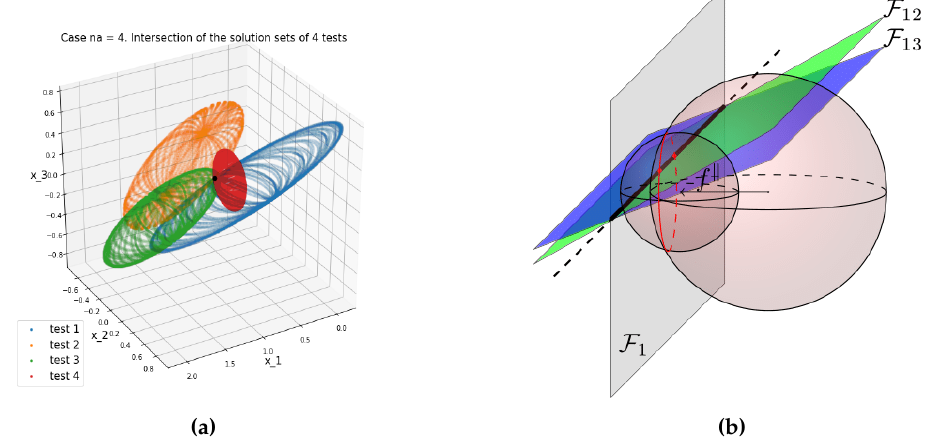
Figure 4. Case n a ≥ 3. ( a ): Case n a = 4. Intersection of four hyperellipsoids, set of the solutions x a of four different tests, in the space R n a = 4 ; ( b ): Case n a = 3. Example of three tests for which the solution has an intersection bigger than one single point. The three ( n a − 1 ) -dimensional subspaces F 1 , F 12 , F 13 in the space generated by A a ,1 intersect in a line and their three orthogonal vectors are not linearly